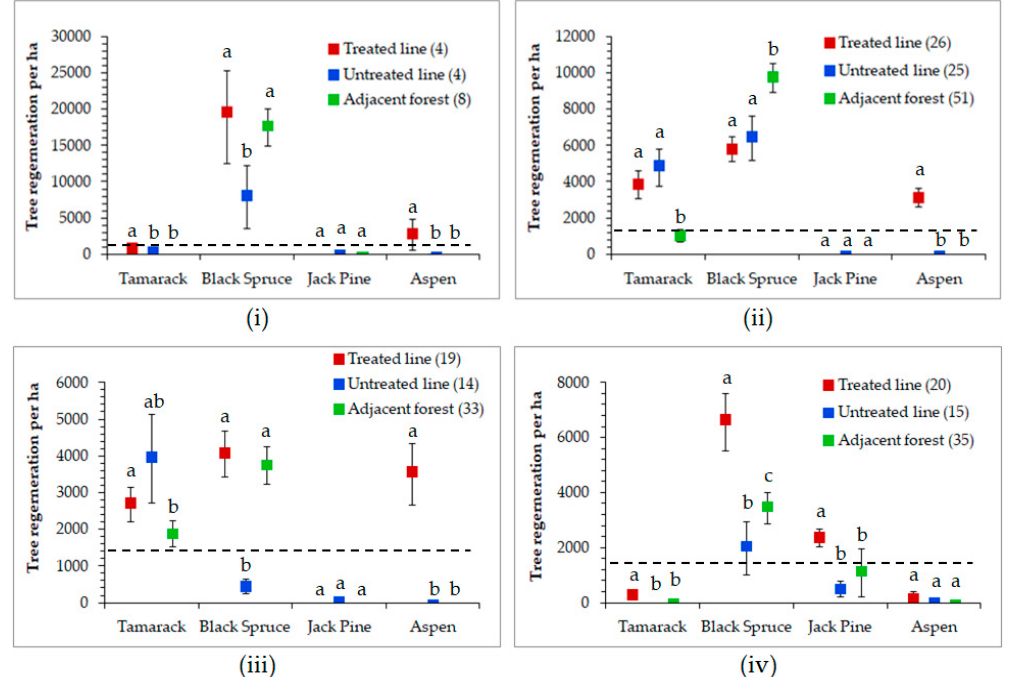
Figure A1. Mean and standard error (error bars) of tree regeneration (DBH < 1 cm), across four tree species and three treatments. Where each ecosite is represented by: ( i ) bog; ( ii ) poor fen; ( iii ) rich fen; and ( iv ) poor mesic. Significance of treatments within each ecosite was tested with a pairwise comparison (Bonferroni adjustment) with different letters indicating significant ( p < 0.017) differences within a species. Note, dashed line represents the amount of planted stems per hectare in treated lines (1300 stems/ha). Scales vary.